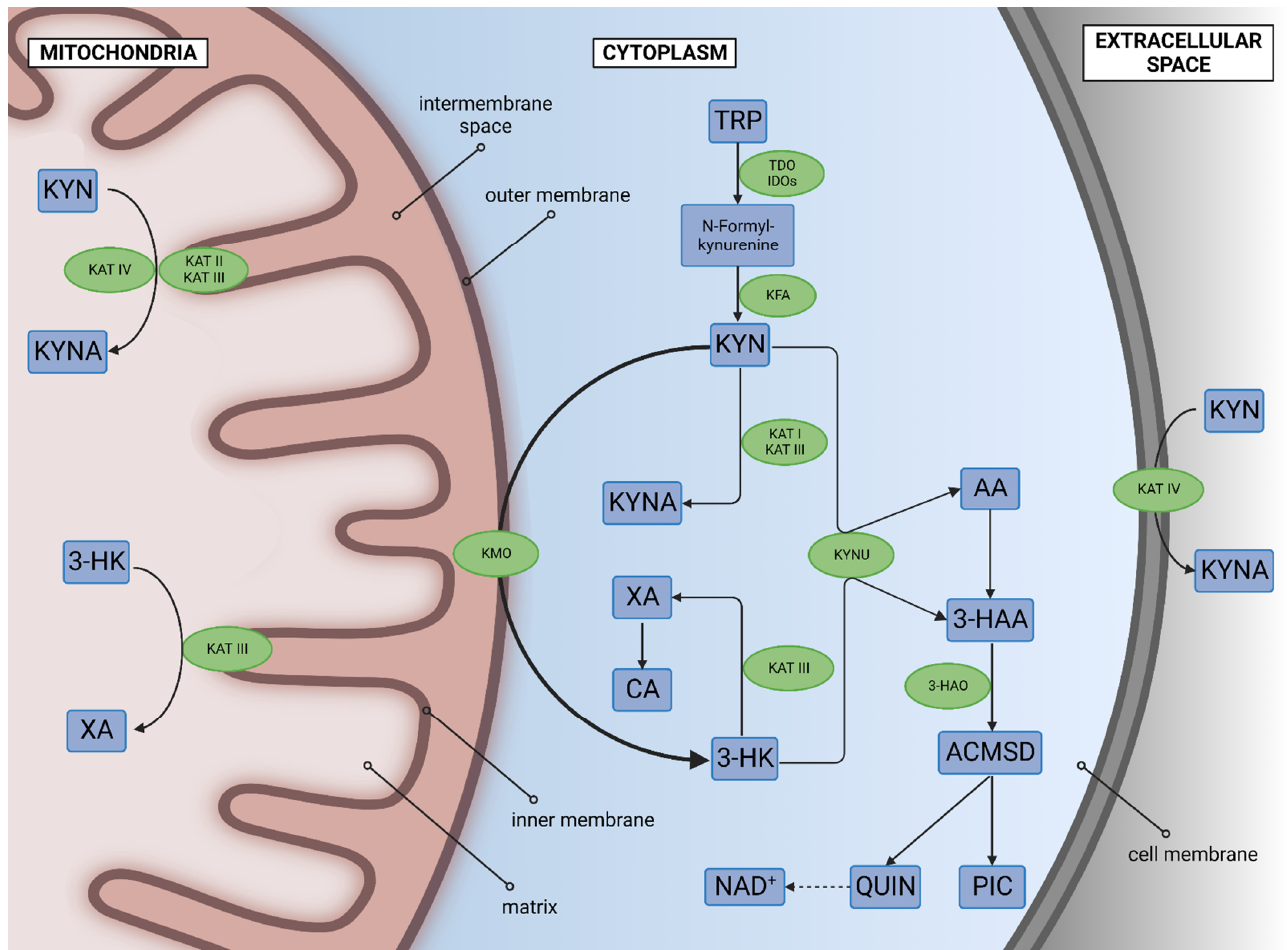
Figure 2. The tryptophan (Trp)–kynurenine (KYN) metabolic system and the subcellular location of the enzymes. More than 95% of L-Trp enters the KYN system producing multifarious biomolecules. The main enzymes of the KYN system are tryptophan 2,3-dioxygenase (TDO), indoleamine 2,3-dioxygenases (IDOs), kynurenine formamidase (KFA), kynurenine 3-monooxygenase (KMO), kynurenine aminotransferases (KATs), and kynureninase (KYNU). Most of the enzymes are located in the cytosol. However, KMO is located in the outer membrane of mitochondria; KAT II and KAT III are in the inner membrane of mitochondria; and KAT IV is in the matrix of mitochondria and in the plasma membrane. The main metabolites are L-KYN, kynurenic acid (KYNA), 3-hydroxy-L- kynurenine (3-HK), quinolinic acid (QUIN), and nicotinamide adenine dinucleotide (NAD + )